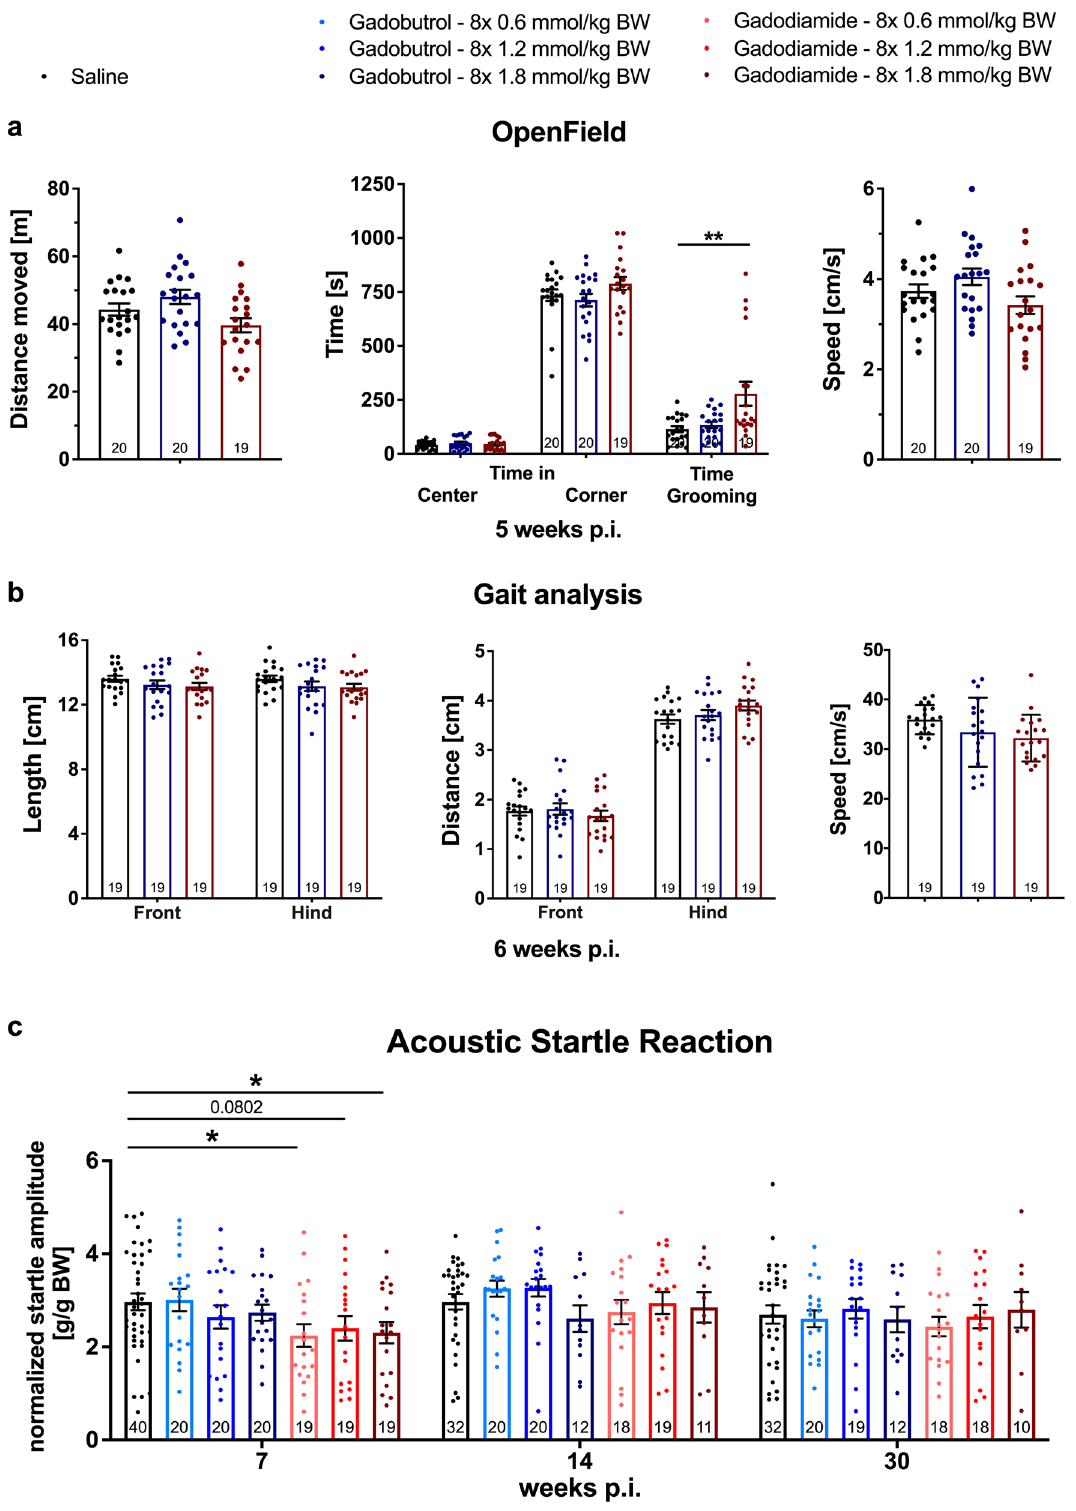
Figure 2. Early and transient reduction in acoustic startle reaction in gadodiamide-treated animals and comparable parameters in the OpenField test and gait analysis. ( a ) Explorative and grooming behavior 5 weeks p.i in the OpenField test. ( b ) Stride length of front and hind paws, distance between either front or hind paws (base of support) and average speed of the animals measured with the CatWalk XT system test 6 weeks p.i. ( c ) Startle reaction to 120 dB acoustic stimuli 7, 14 and 30 weeks p.i. Data represent mean ± SEM; n is indicated in the columns; * p < 0.05; ** p <